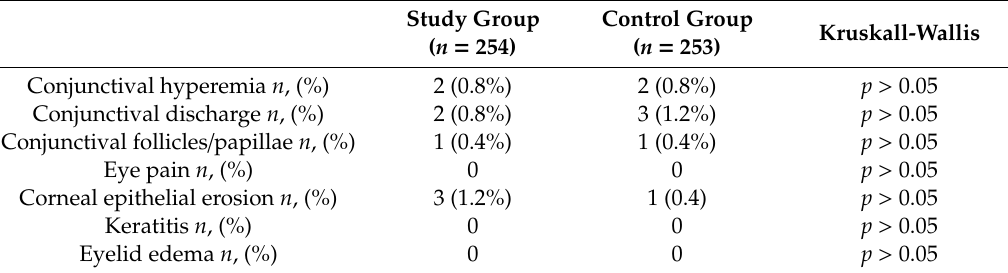
Table 4. Rate of ocular adverse events.